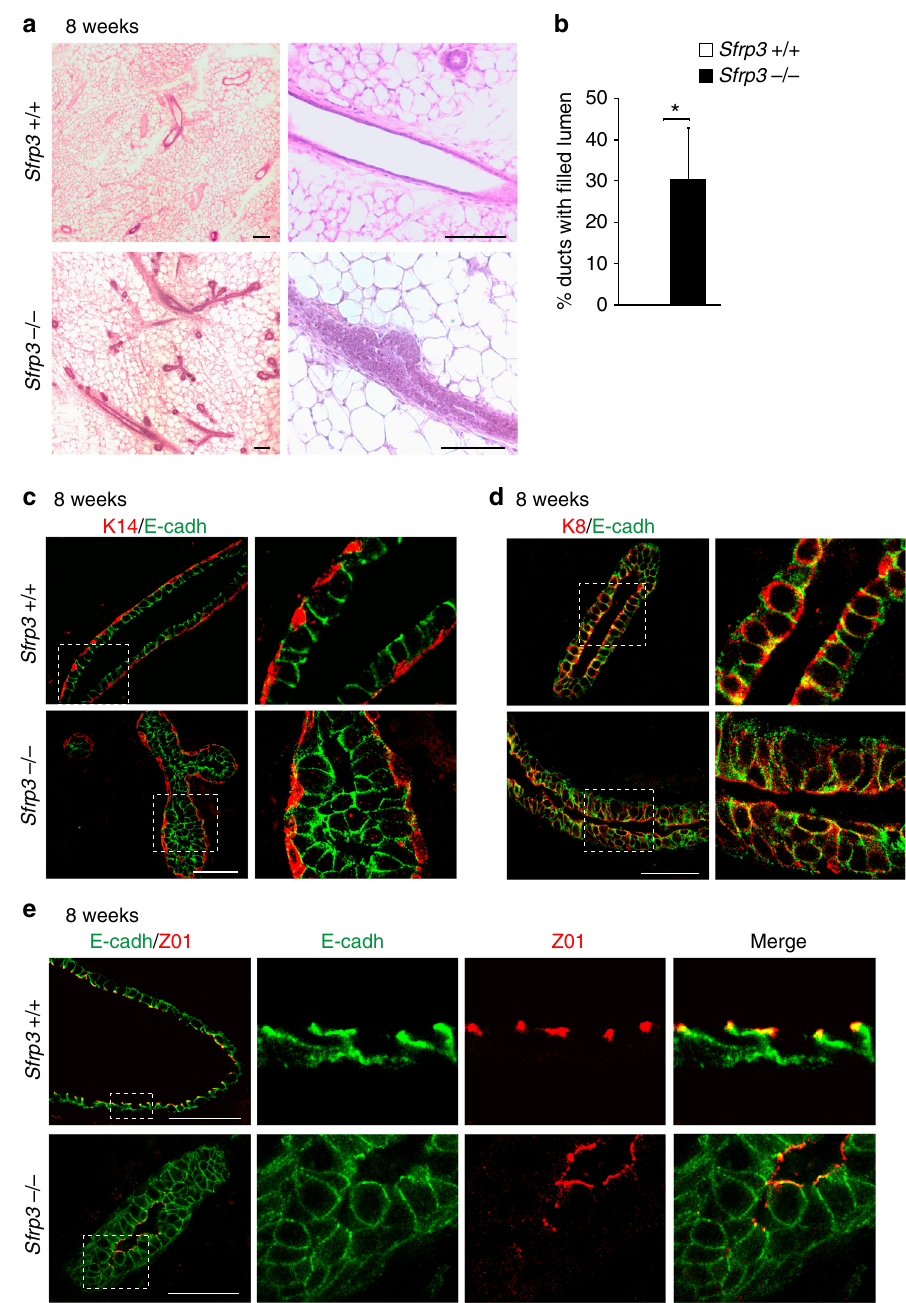
Fig. 2 Sfrp3 loss disrupts lumen formation and epithelial architecture of ducts. a Representative images of HE-stained mammary glands from Sfrp3 + / + and Sfrp3 − / − virgin females at 8 weeks of age. Scale bar: 100 µ m. b Quantitative analysis of the luminal fi lling phenotype showing an increase in the number of ducts with occluded lumen in Sfrp3 − / − compared to Sfrp3 + / + females at 8 weeks of age. n = 2 Sfrp3 + / + ; 3 Sfrp3 − / − . Data represent mean ± SD (* p < 0.05). c , d Immuno fl uorescence staining for Keratin 14 (K14) and E-cadherin (E-cadh) ( c ) and for Keratin8 (K8) and E-cadherin ( d ) on mammary sections of 8 weeks old females. The magni fi cation of each bracketed area is shown on right side. Scale bar: 50 µ m. e Immuno fl uorescence staining for E-cadherin and ZO1 on mammary sections of 8 weeks old females. c – e Images are representative of at least 10 MG sections analysed in 5 different experiments. Scale bar: 50 µ m. See also Supplementary Fig. 2. Source data are provided as a Source Data fi (Supplementary Fig. 4c), precluding that the branching pheno- type of Sfrp3 − / − mice is due to an increase in hormone levels. Indeed, in Sfrp3 − / − males (complete absence of ovarian function) did not show any induction of the mammary tree (Supplementary Fig. 4d). In summary, these results indicate that stromal Sfrp3 modulated epithelial MG development only in a hormonally stimulated environment.